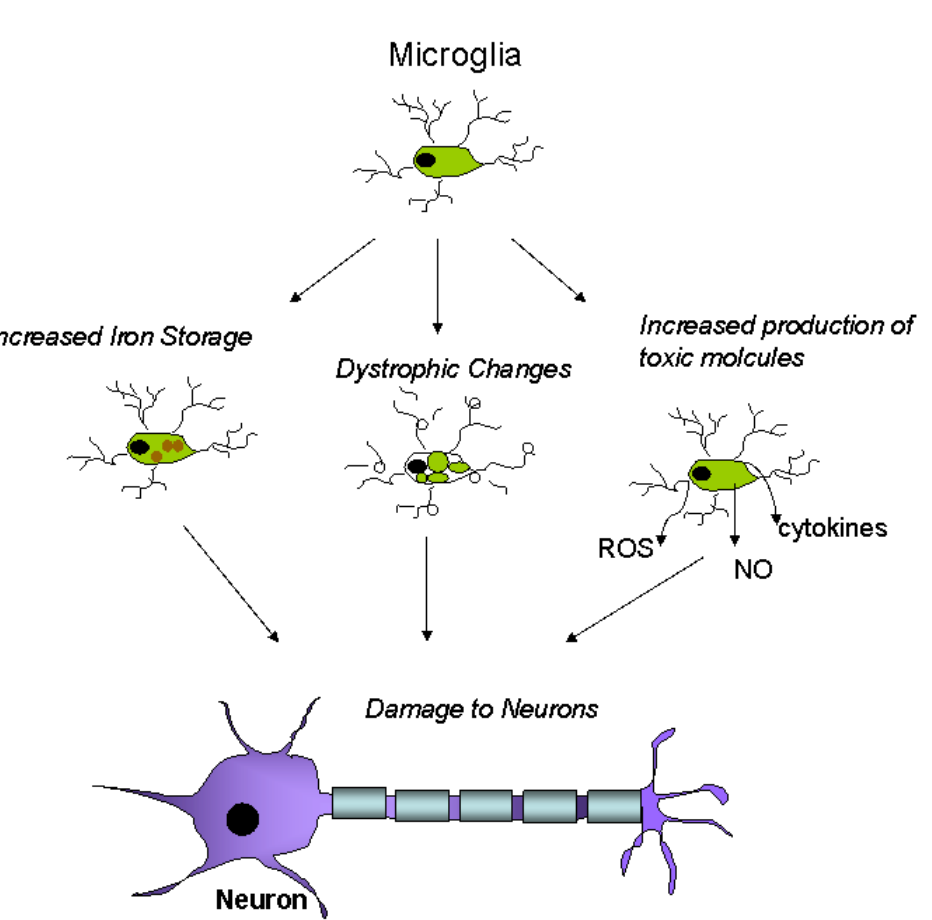
FIGURE 2. Age-related changes in microglia that could influence neuronal survival. Microglia in the aging brain include a high percentage of microglia that show no changes, but a proportion of microglia show a number of changes that include increased iron storage, dystrophic changes, and increased production of potentially toxic substances, such as cytokines, NO, and ROS. Microglia with increased iron storage could potentially generate increased levels of ROS through Fenton chemistry. The combination of these changes could damage neurons and induce changes associated with aging in the